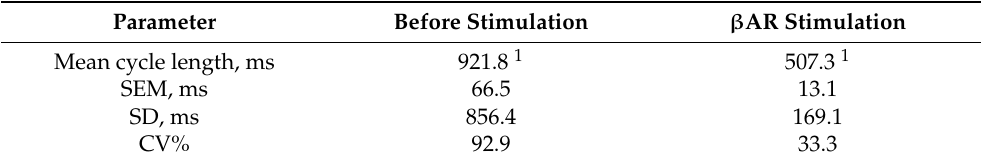
Table 1. The effect of β AR stimulation on cycle length measured in a population of 166 SAN cells that generated spontaneous AP-induced Ca transients; SEM, standard error of mean; SD, standard deviation, CV% = 100 × SD/Mean, coefficient of variation. Parameter Before Stimulation β AR Stimulation Mean cycle length,